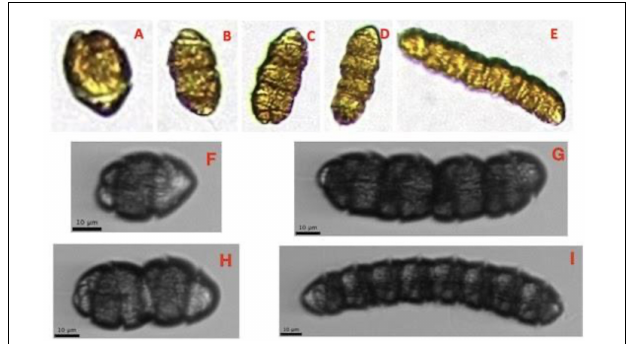
FIGURE 1 | Images of Margalefidinium polykrikoides generated from different imaging instruments. The top row (A–E) shows images of single and multiple cell chains produced by a PlanktoScope from unpreserved samples. The second and third rows (F–I) show images of single and multiple cell chains produced by an IFCB from unpreserved samples. The water samples were all taken from the lower Chesapeake Bay in August 2020 and